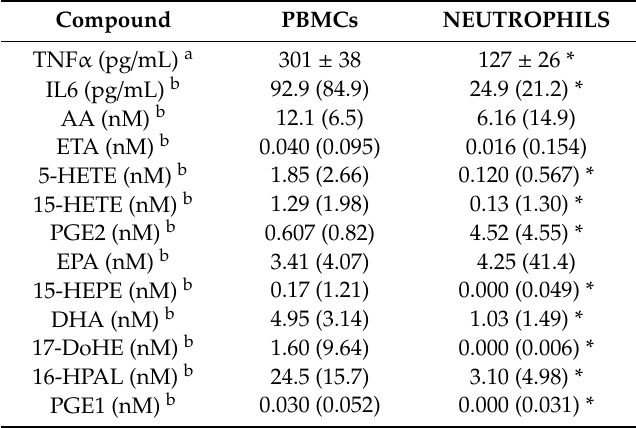
Table 6. In vitro production of cytokines, fatty acids and oxylipins by peripheral blood mononuclear cells (PBMCs) and neutrophils isolated in basal conditions (pre-exercise, no supplementation) and cultured for 2 h at 37 ◦